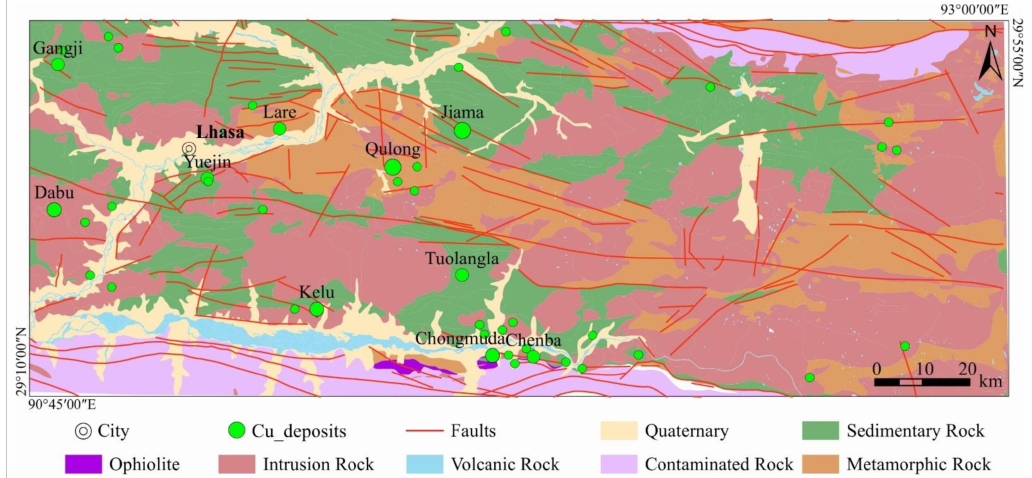
Figure 2. Simplified geological map of the study area.